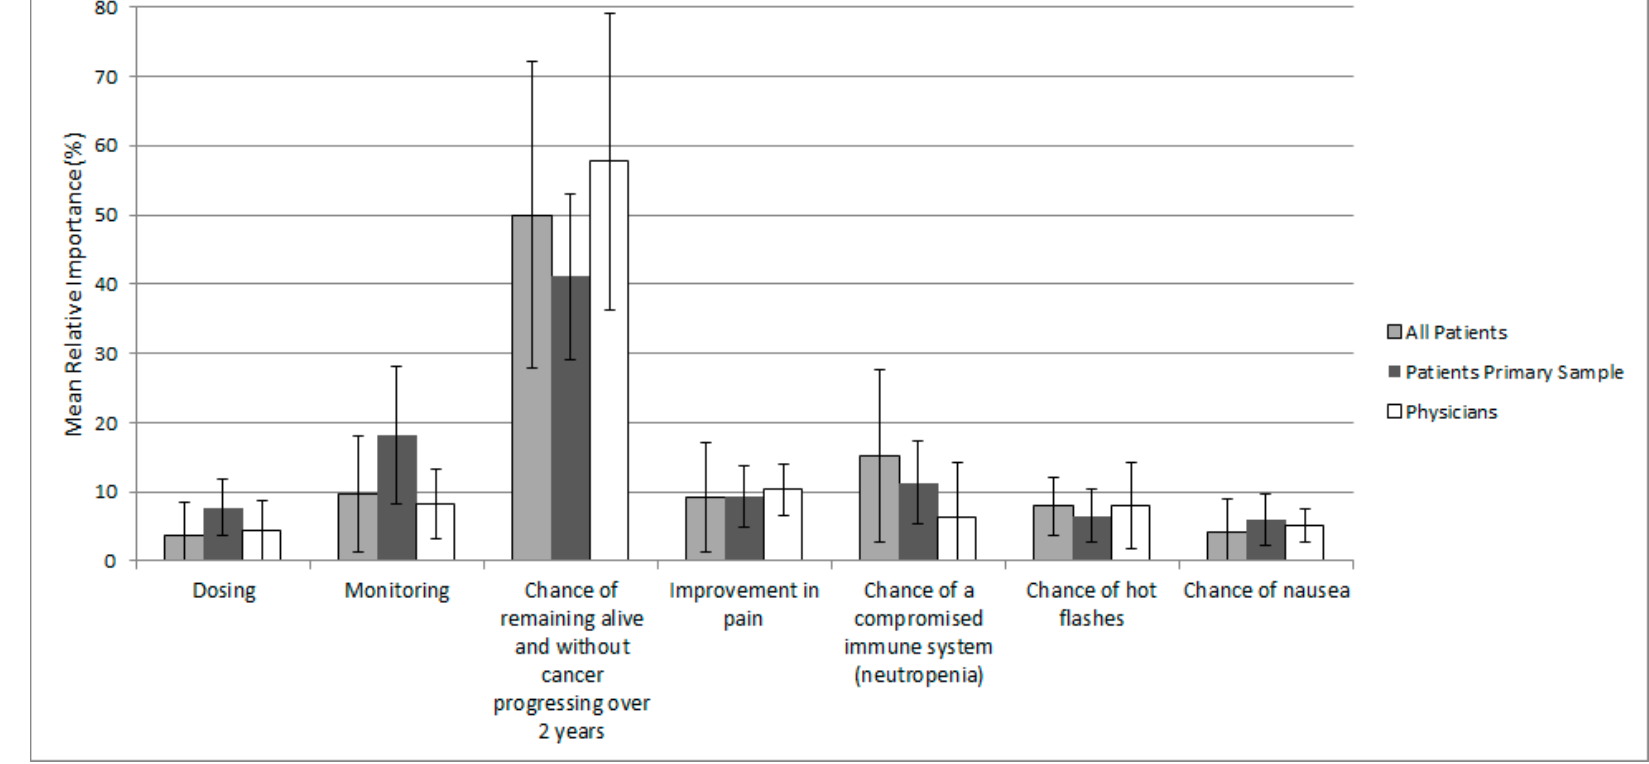
Figure 2. Mean (SD) relative attribute importance for patients and physicians Note: Not all respondents completed every choice task.